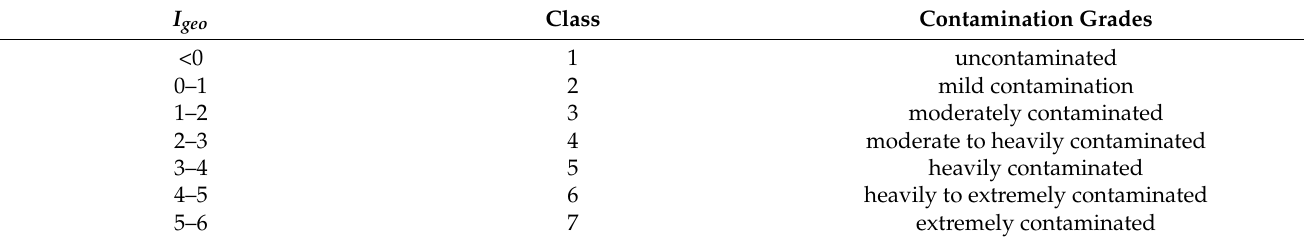
Table 2. The I geo and contamination grades of heavy